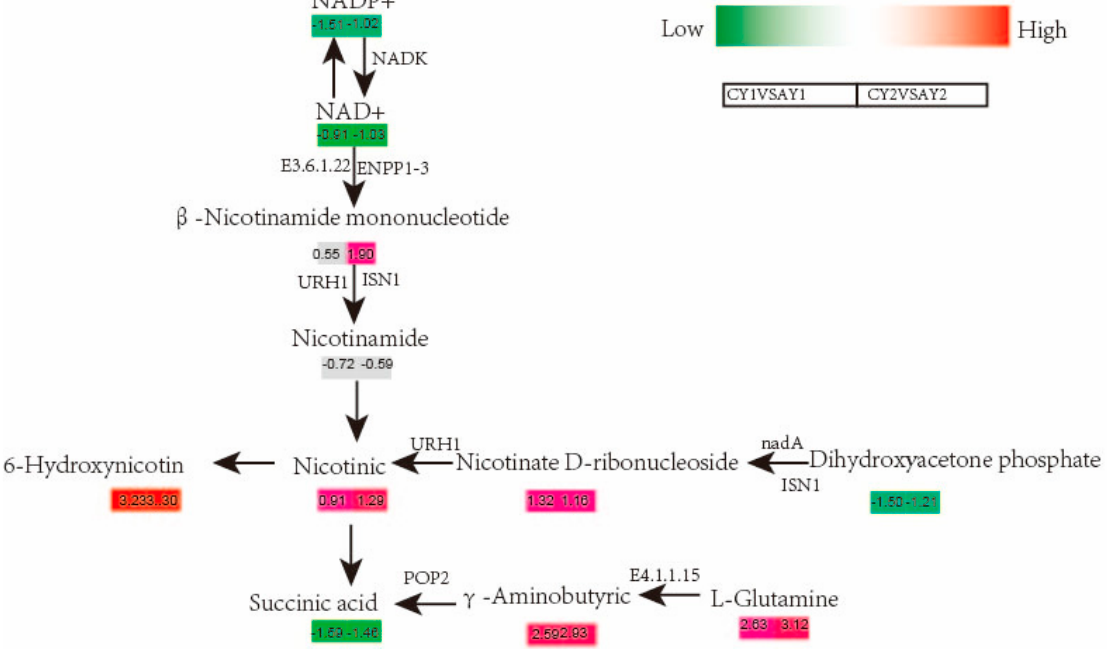
Figure 5. Key metabolism map of nicotinamide under freezing in quinoa: gene expression levels are expressed as FPKM values followed by calculation of their log2FC for different controls, metabolite levels are expressed as log2FC values for different controls, left indicates CY1VSAY1, right indicates CY2VSAY2. NADP+, nicotinamide adenine dinucleotide phosphate; NAD+, nicotinic acid adenine dinucleotide.